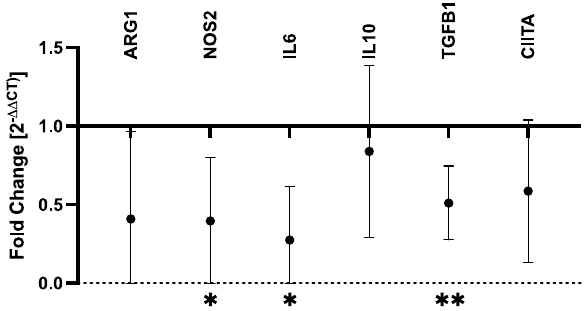
Figure 1. Fold-change in mRNA transcripts in ATRA-treated vs. control canine MDMs. Canine